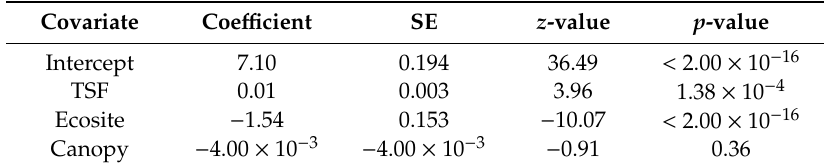
Table 7. Summary table for the top lichen abundance model. TSF = time-since-fire, Canopy = canopy closure. The beta coe ffi cient for ecosite represents lichen biomass in dense conifer with sparse conifer as the reference (Appendix C). SE = standard